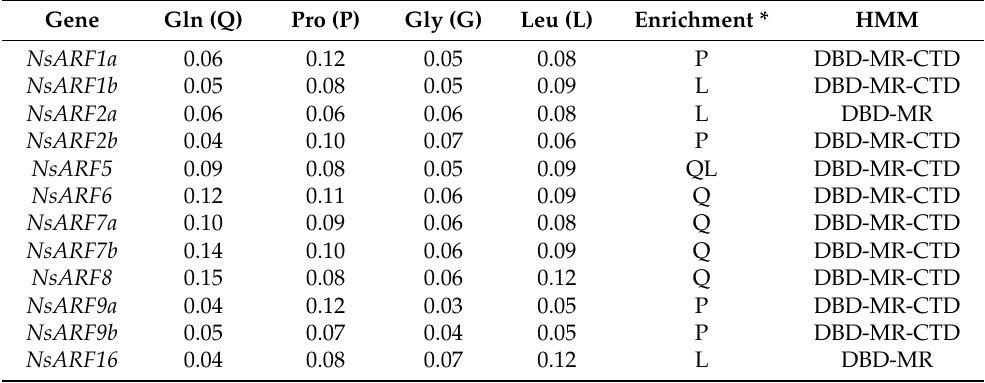
Table 2. Amino acid content of the NsARF gene family MR domain.